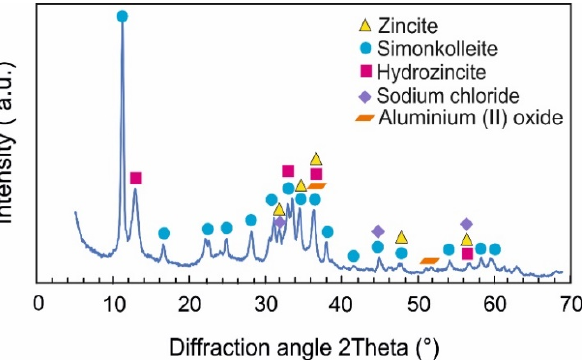
Figure 12. XRD pattern on MZ+3.0Sn annealed sample surface after 1000 h NSST, measured in grazing incident geometry.